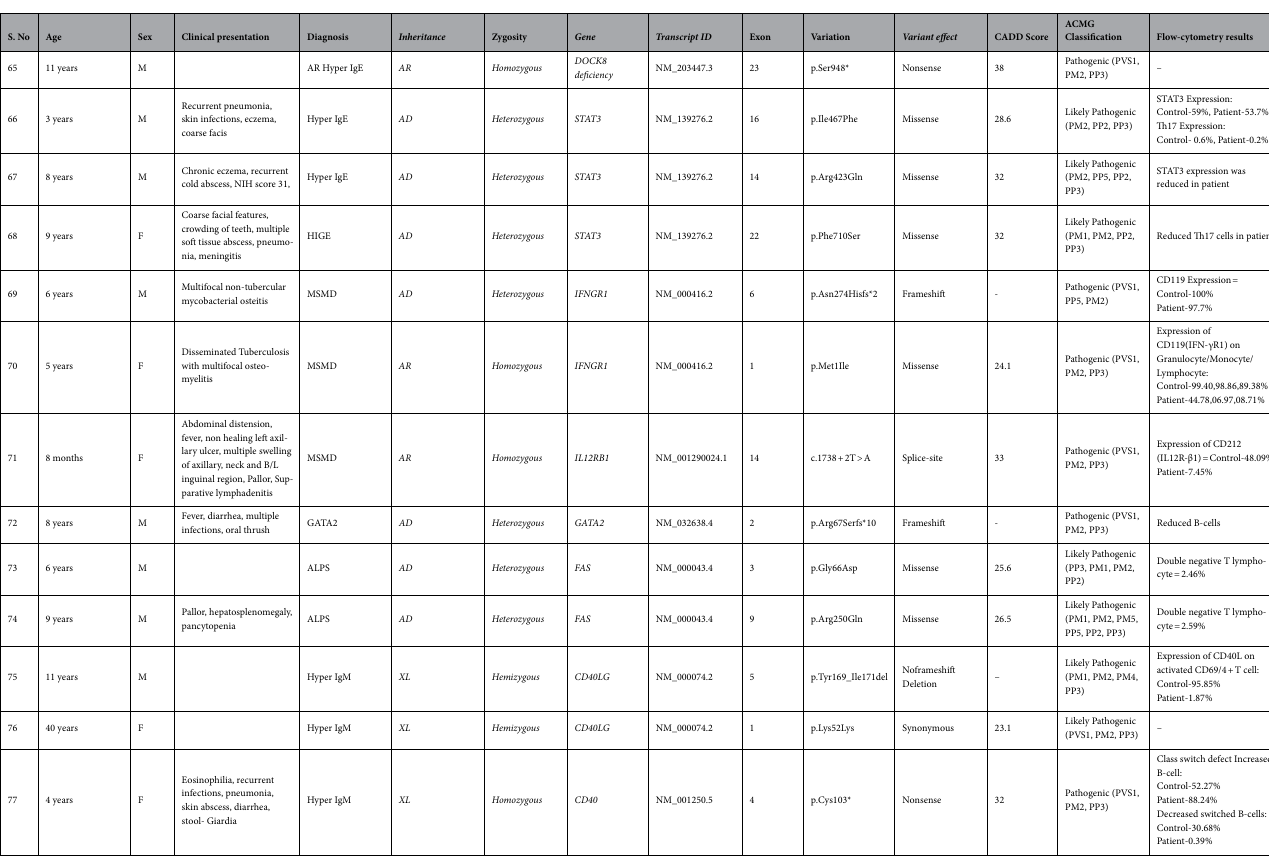
Table 1. Variant detail of patients with various IEI and corresponding flow-cytometry